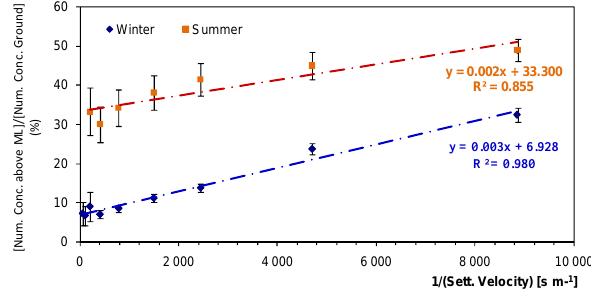
Fig. 8. Linear correlation between the percentage of each coarse size-class found above the ML, and the inverse of settling velocity in winter (a) (DJF months; N profiles=142) and summer (b) (JJA months; N